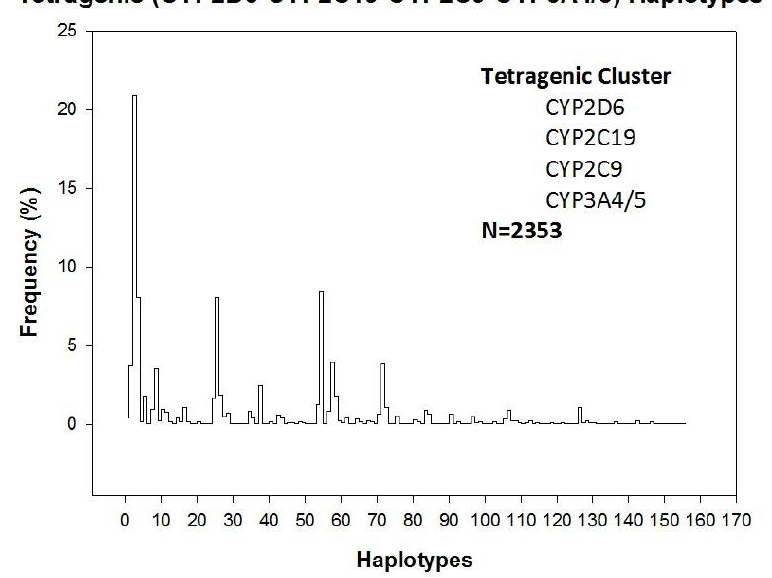
Figure 1. Tetragenic ( CYP2D6-CYP2C19-CYP2C9-CYP3A4/5 ) haplotypes in the Spanish population.